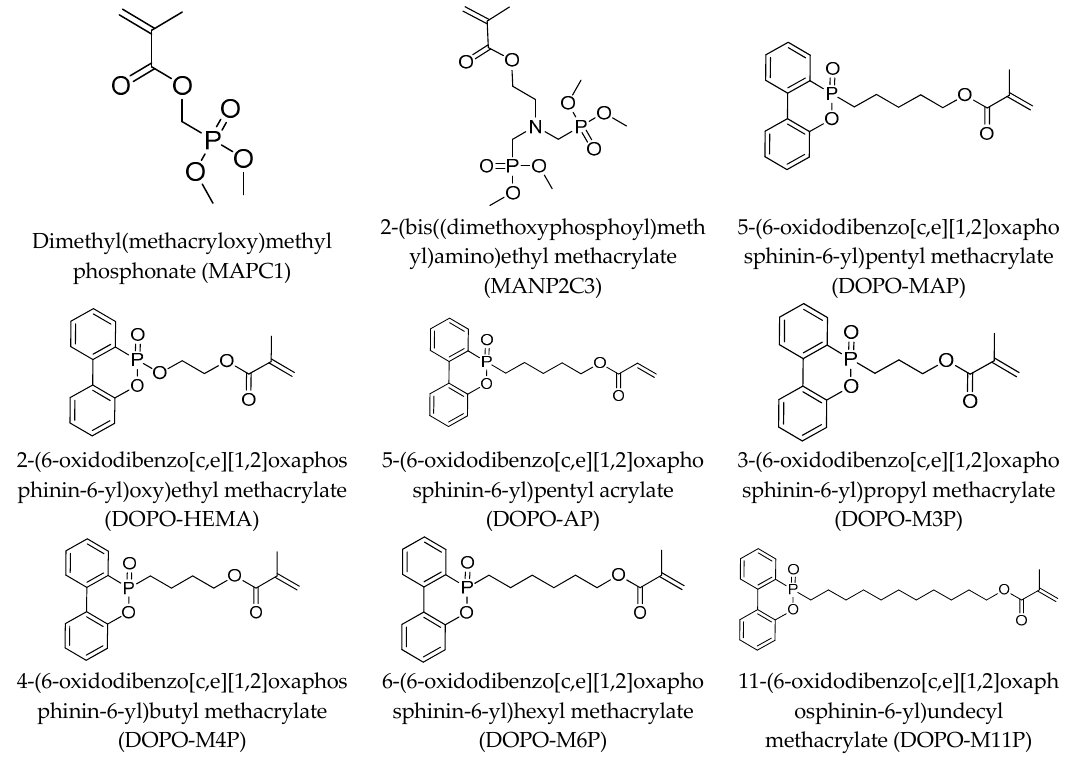
Figure 1. Structure of 9,10-dihydro-9-oxa-10-phosphaphenanthrene-10-oxide (DOPO)-functionalized monomers, MAPC1 and MANP2C3.